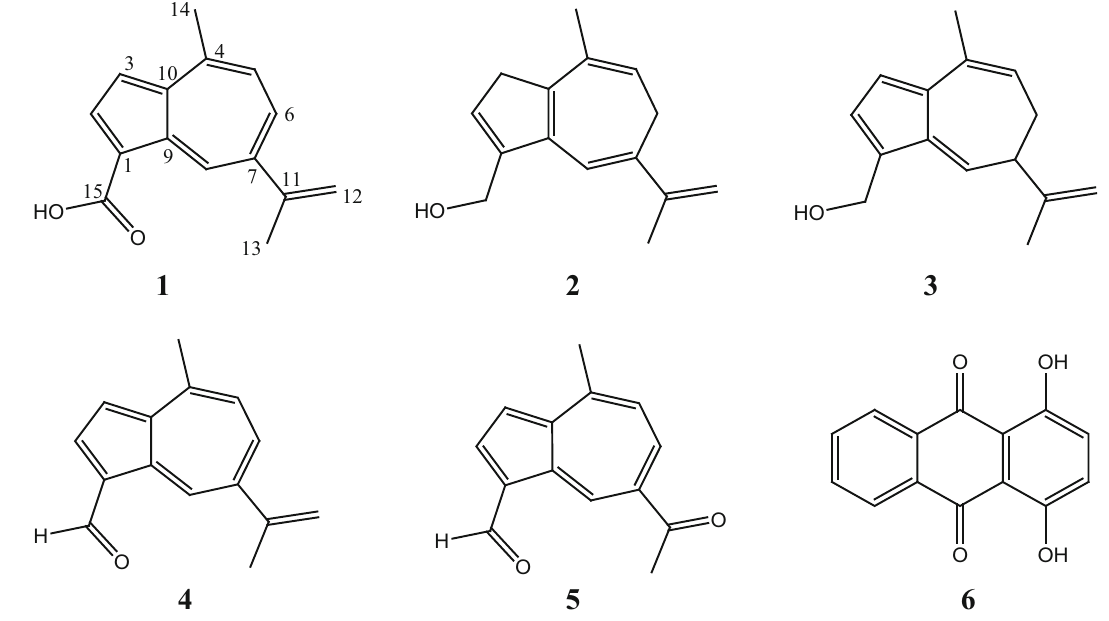
Fig. 1 Structures of pigments 1 – 6 isolated from the fruiting bodies of Lactarius